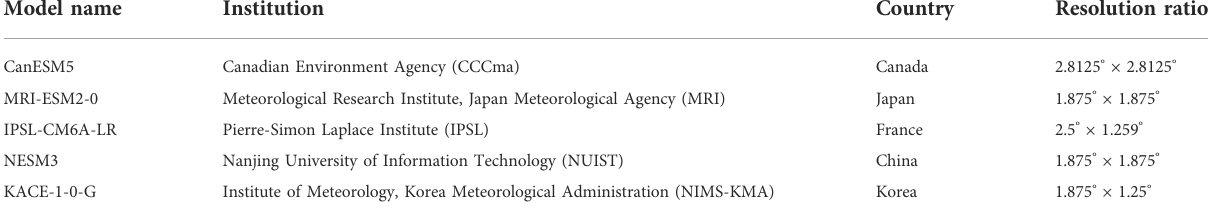
TABLE 1 Information of 5 global climate